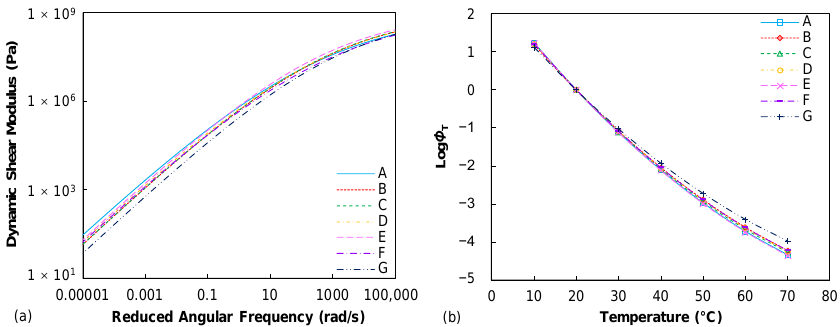
Figure 2. Frequency sweep test results (reference temperature: 20 °C): ( a ) dynamic shear modulus mastercurves; ( b ) TTSP shift factors.